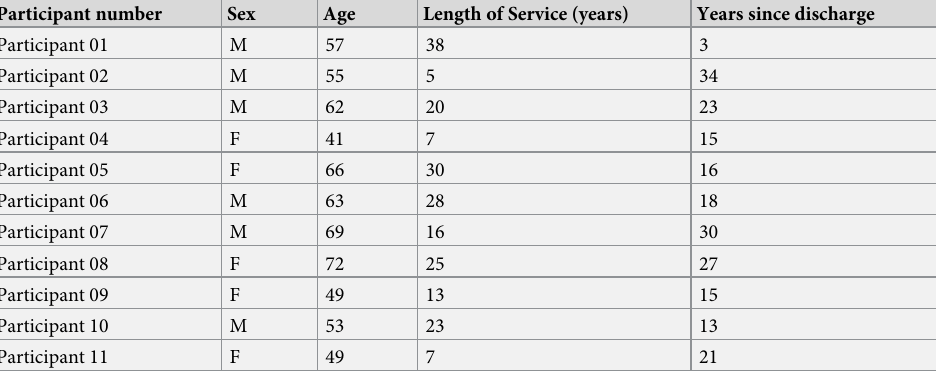
Table 1. Summary of